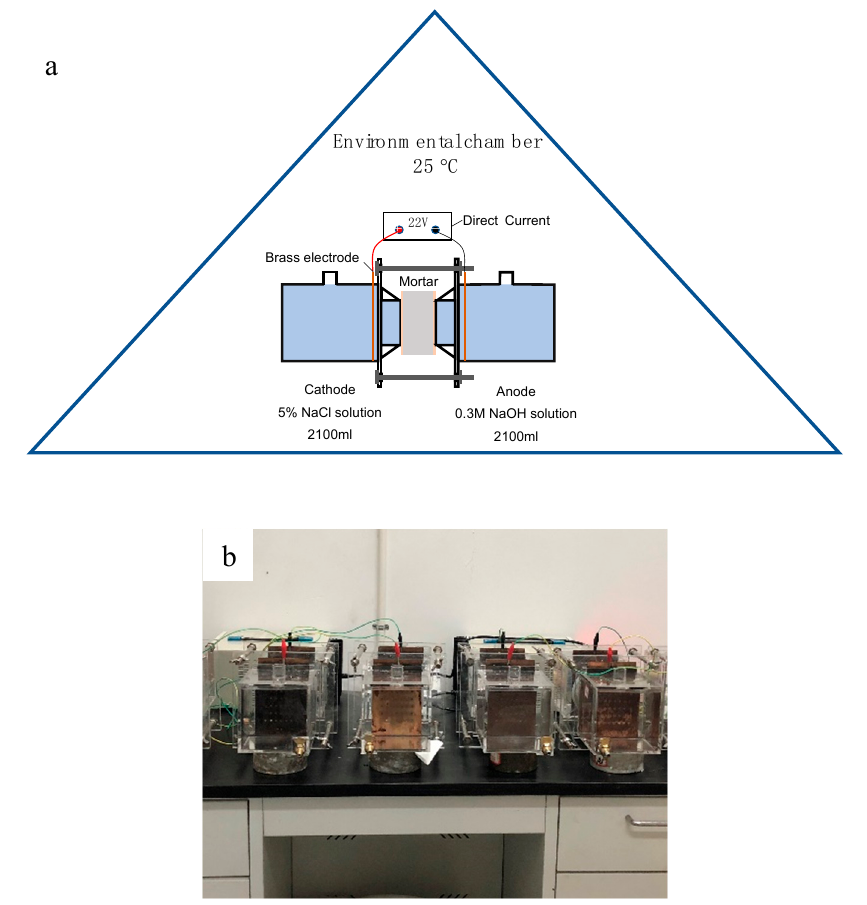
Figure 2. The configuration of chloride diffusion test setup: ( a ) configuration of the test setup. ( b ) samples under test.